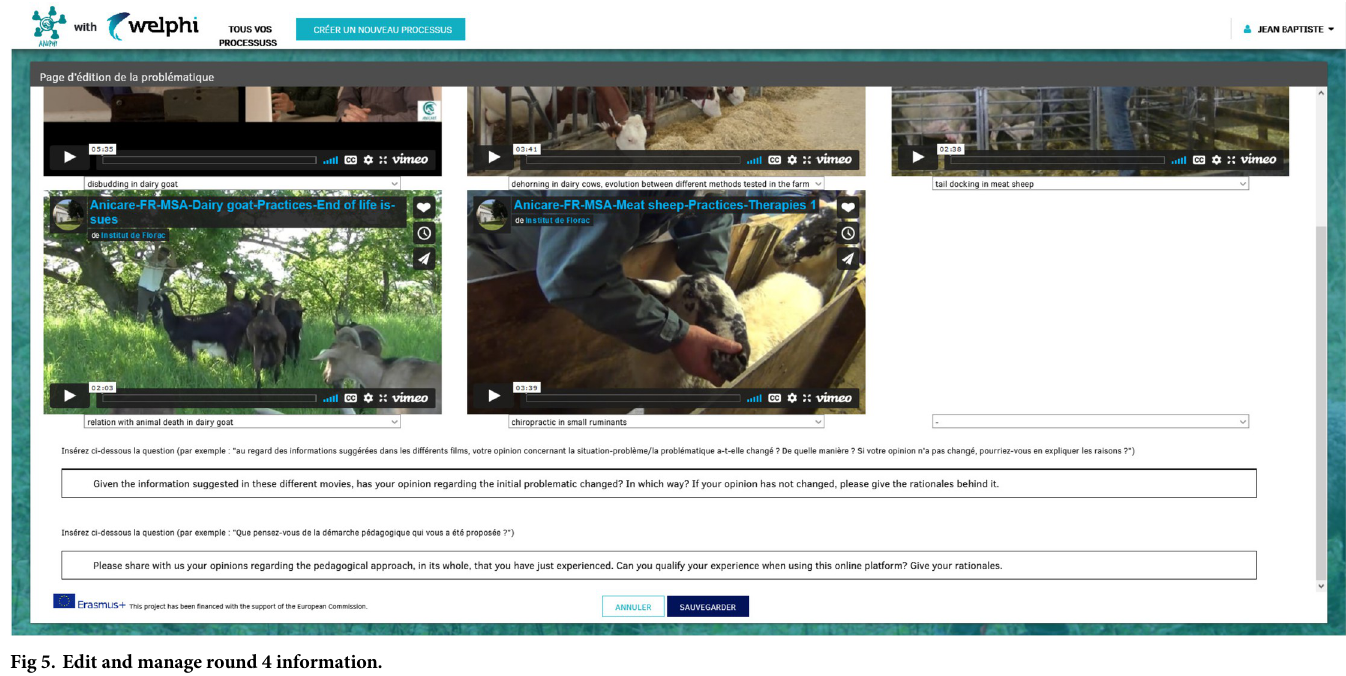
Fig 5. Edit and manage round 4 information.